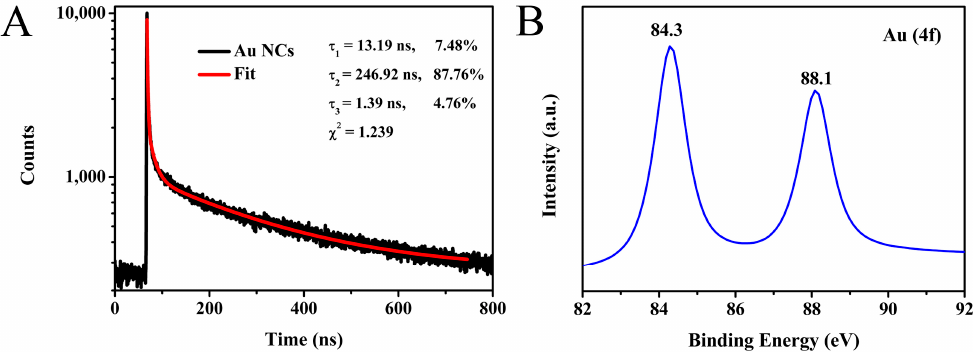
Figure 4. Fluorescence lifetimes of Au NCs in aqueous solution ( A ); data were collected at 565 nm with excitation at 375 nm. X-ray photoelectron spectroscopy (XPS) spectra of Au 4f of Au NCs ( B ).